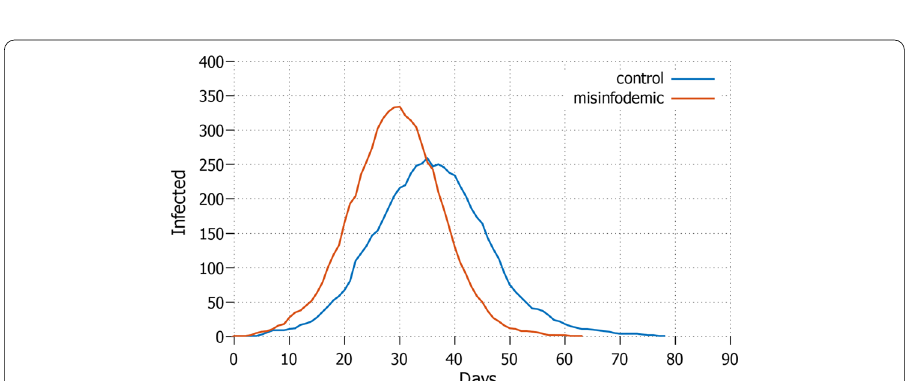
Fig. 10 Essential activities, protective measures applied without detection Total cases without detection of infected and only essential workers allowed to